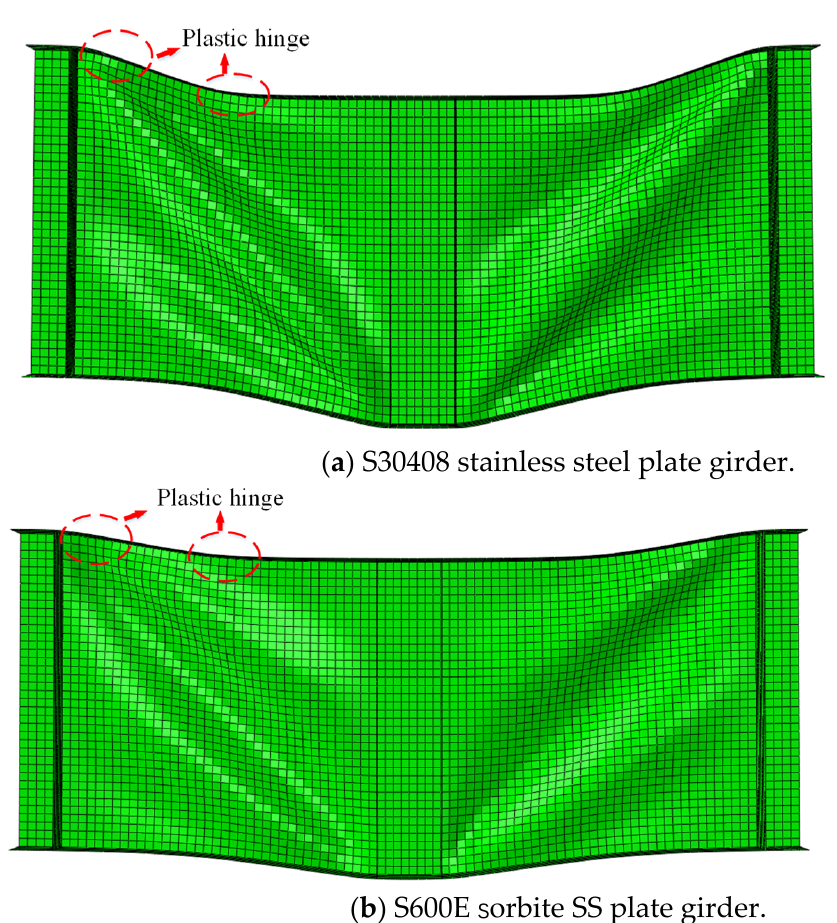
Figure 13. Failure behavior of the S30408 and S600E stainless steel plate girders.